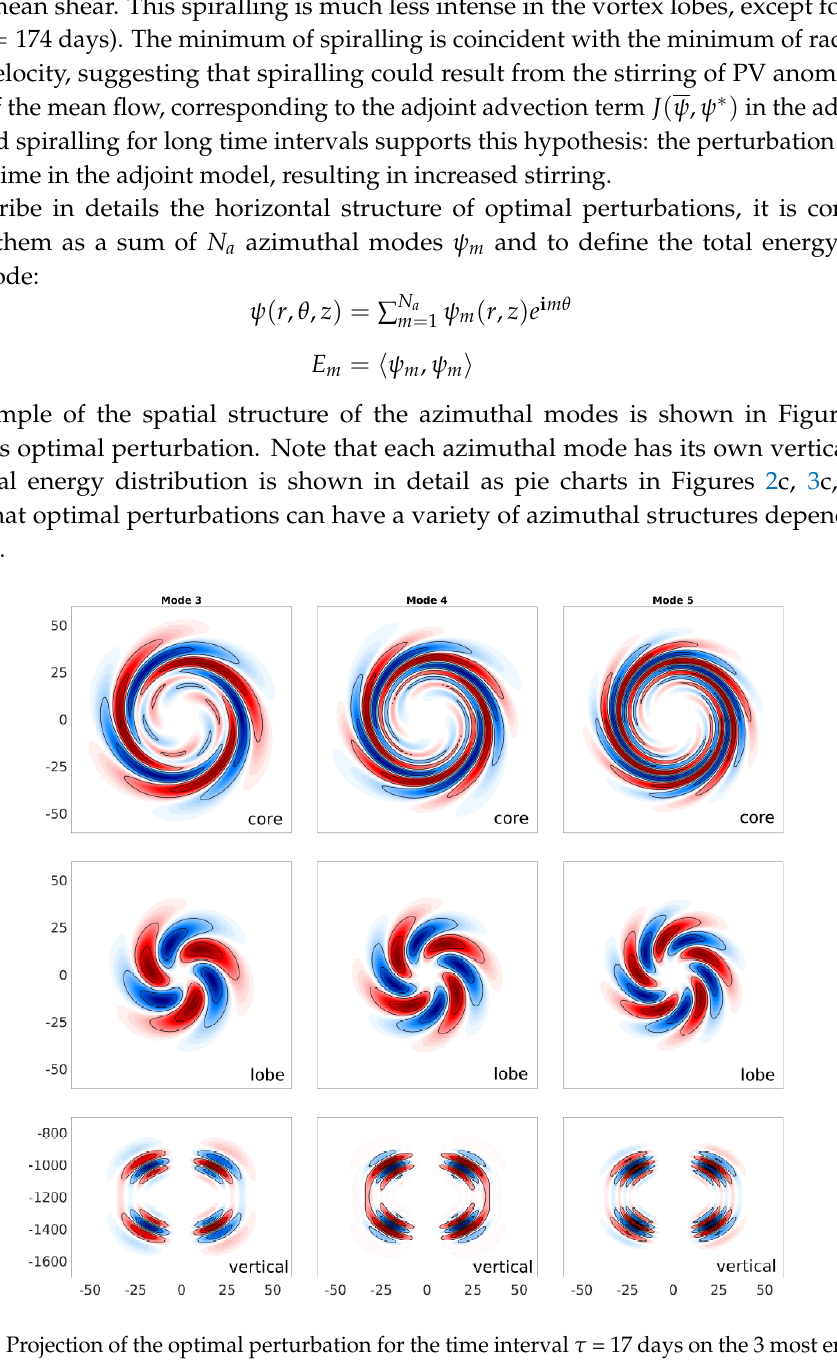
Figure 6. Projection of the optimal perturbation for the time interval τ = 17 days on the 3 most energetic azimuthal modes (m = 3, 4, 5). The top panels show PVA horizontal sections through the vortex core; the middle panels show PVA horizontal sections through the vortex lobes and the bottom panels show PVA vertical